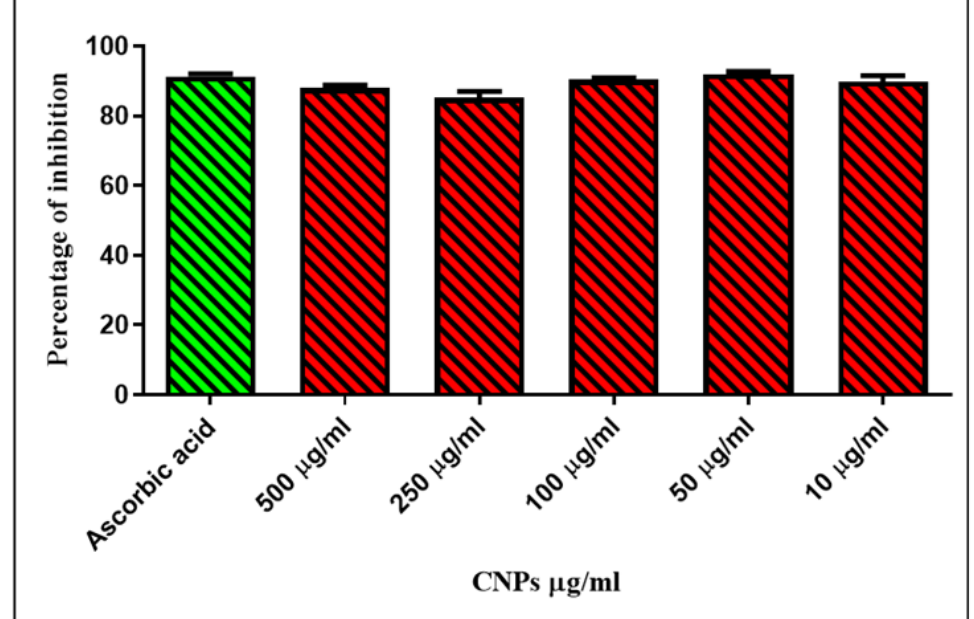
Figure 7. H 2 O 2 scavenging percentage of MAL-CNPs.